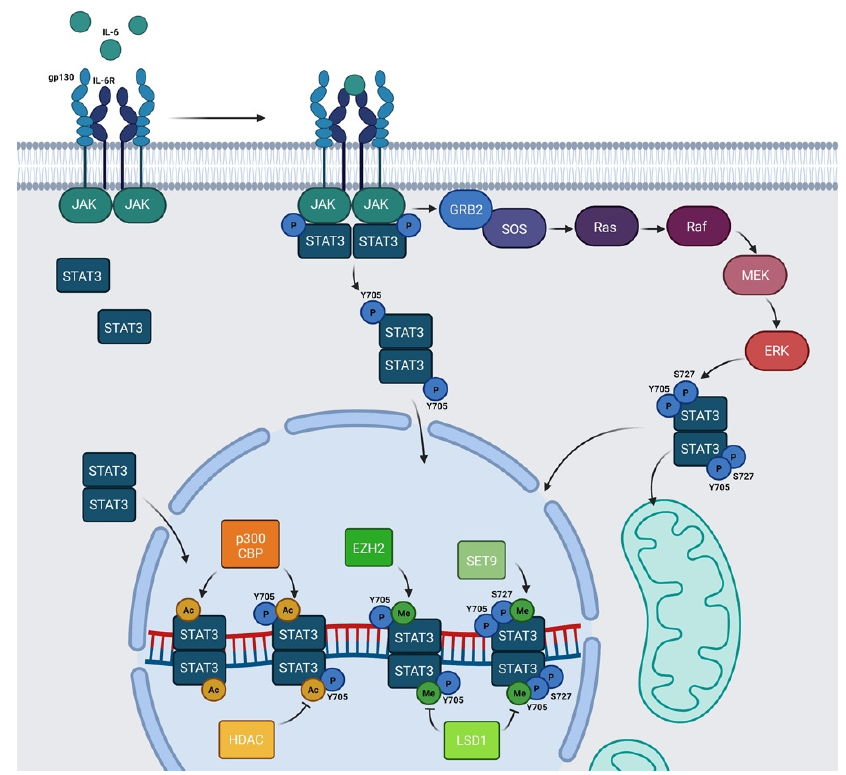
Figure 2. Schematic representation of IL-6/JAK/STAT3 pathway: IL-6 family members recognize their cognate transmembrane receptors and transmembrane proteins associated with the receptors trigger the activation of JAKs. Activated JAKs phosphorylate Y705 of STAT3 and pSTAT3 Y705 mi- grates to the nucleus. In the nucleus, STAT3 can be acetylated by p300/CBP and methylated by SET9 or by EZH2. HDAC and LSD1 inhibit AcSTAT3 and MeSTAT3, respectively. The Ras/Raf/MEK/ERK pathway determines S727 phosphorylation. Y705 and S727 are both required for mitochondrial functions of STAT3. Alternatively, unphosphorylated STAT3 (U-STAT3) can also regulate specific nuclear targets. Created with BioRender.com.